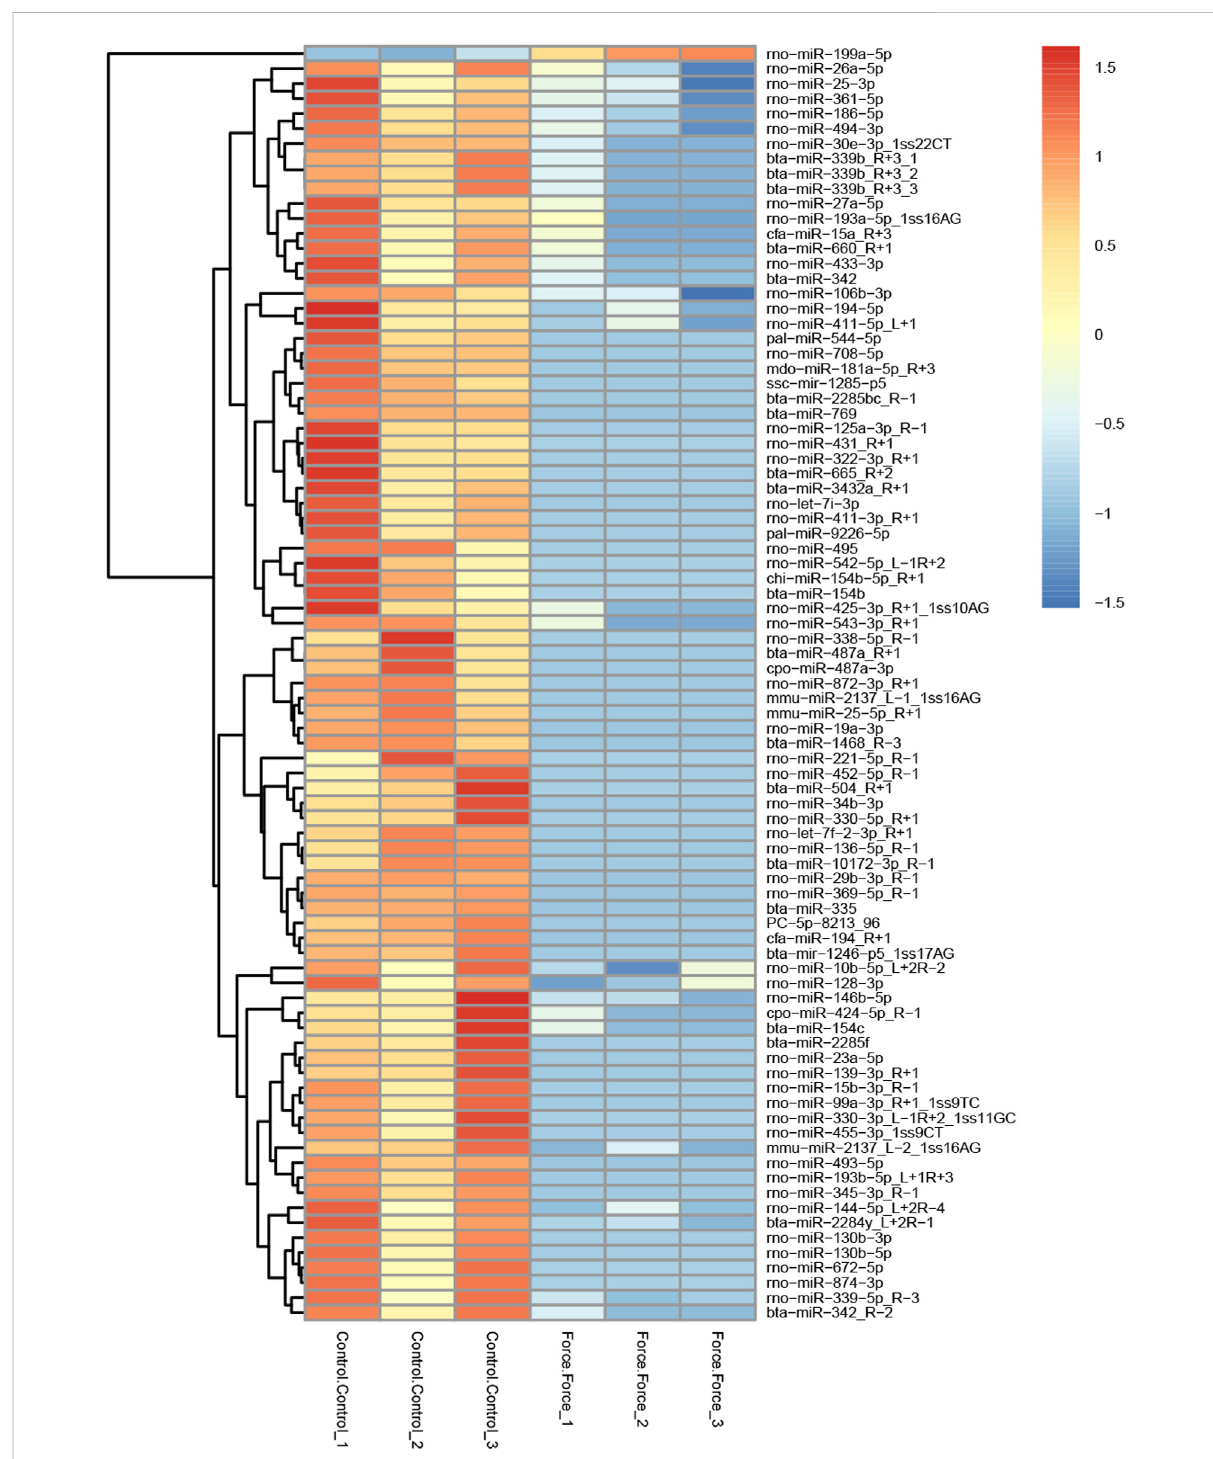
FIGURE 4 miRNAs showing signi fi cantly differential expression levels between the Force-Exo and Control-Exo groups were grouped hierarchically. The sample ’ s log2 (expression value plus+1) is plotted on the x -axis, while gene expression is plotted on the y -axis. The color from red to blue indicates the expression of miRNAs from high to